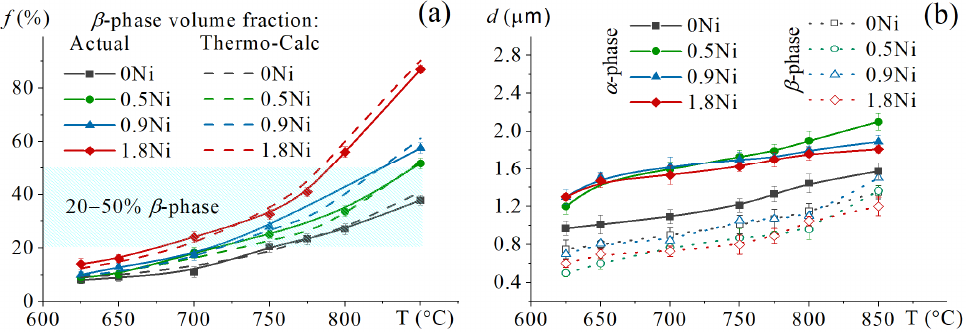
Figure 4. ( a ) Volume fraction ( f ) and ( b ) grain size of the α and β phases vs. annealing temperature for the investigated alloys.